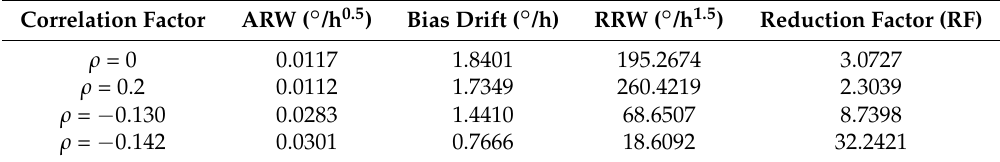
Figure 9. Plot of the compared Allan variance results with different correlation factors ( ρ = − 0.142, − 0.13, 0, 0.2). Table 1. Filtering results of the gyroscope array with different correlation factor.